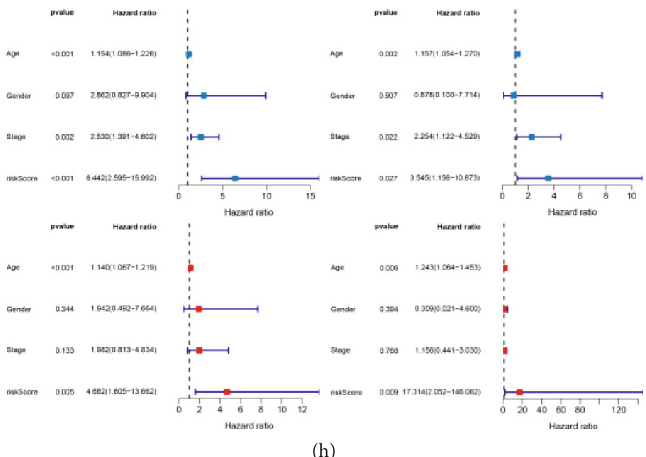
Figure 4: Construction and validation of Ferr-LPM. (a, b) The K-M curves showed that the high LPM_score group had inferior OS in the test set (a) and training set (b). (c – e) ROC curves of 1, 3, 5, and 10-year OS for the test set (c), training set (d), and total set (e). (f) Alluvial diagram of gene clusters in groups with di ff erent LPM_score subtypes and survival status in TCGA cohort. (g) Strati fi ed analysis of Ferr- associated lncRNAs, risk scores, and clinical factors. (h) Independent prognostic analysis of